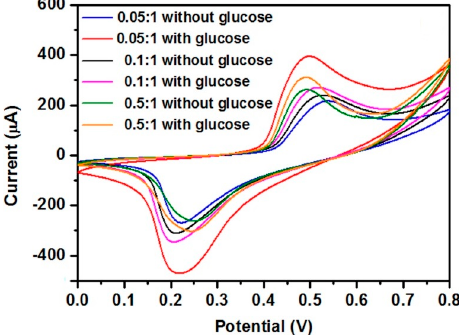
Figure 6. CVs of CeO 2 /Ni(OH) 2 /CPE with different Ce:Ni molar ratios in the absence and presence of 1 mM glucose in 0.1 M NaOH solution at 50 mV/s scan rate.